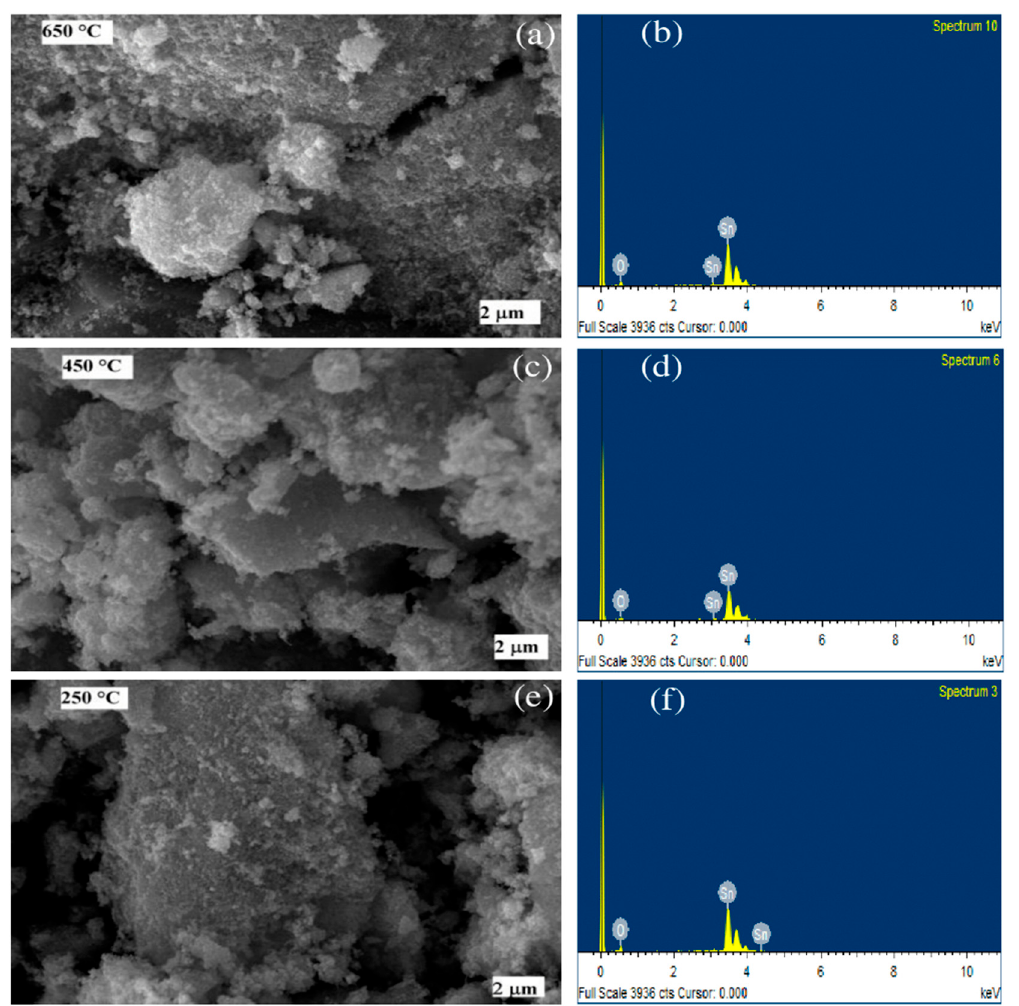
Figure 2. FTIR spectra of SnO 2 nanoparticles at various calcination temperatures.